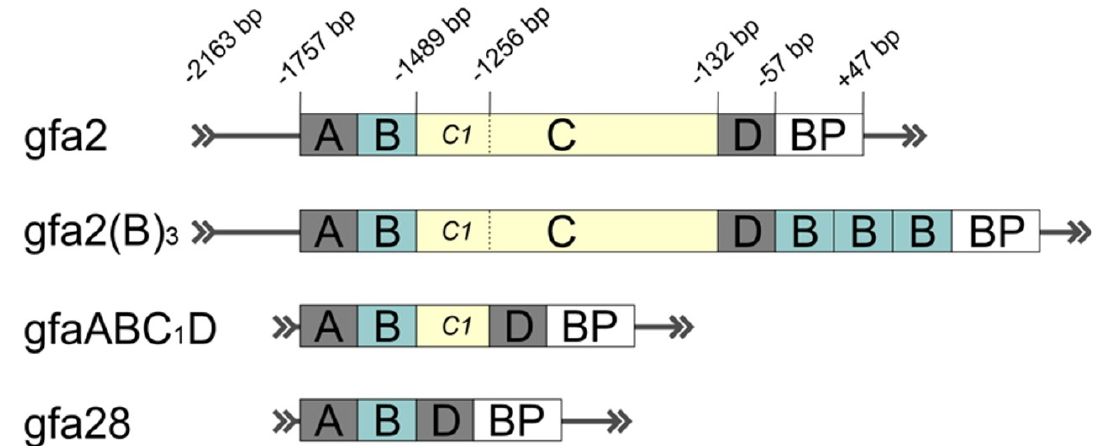
Figure 1. Schematic representation of characterized promoter isoforms for astrocytic targeting constructed based on human GFAP gene (for details, see [99,134]). Letters A–D indicate enhancer regions, BP–basal promoter. Relative distances from the transcriptional start site (TSS) are provided in bp (base pairs). Arrows show the direction of transcription.